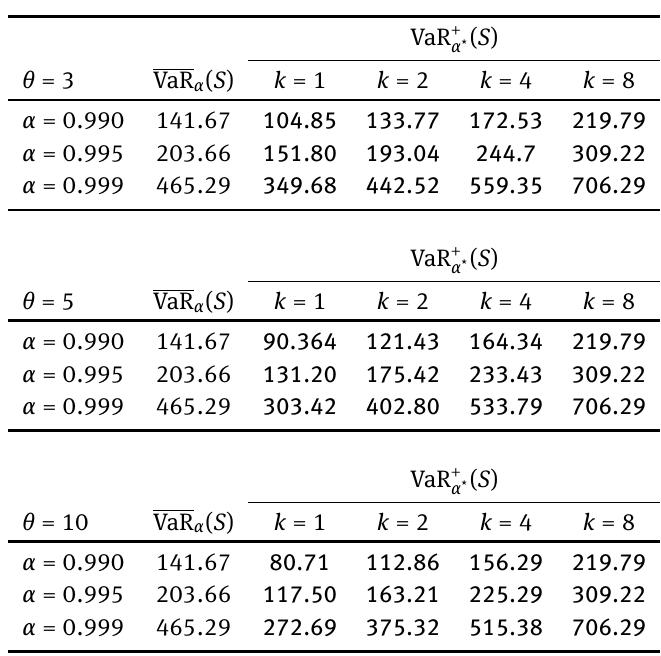
Table 6 Values for VaR + ( S ) (see (3.2)) for a risk vector of n = 8 risks identically distributed as a Pareto(2) under the α * framework described in Section